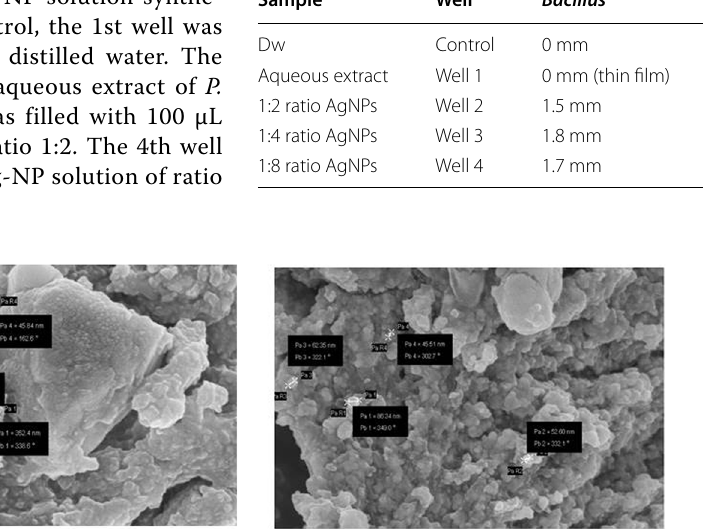
Fig. 7 FESEM image of ( A ) 1:4 AgNPs & ( B ) 1:8 AgNPs synthesized from Polygonum plebeium aqueous leaf extract